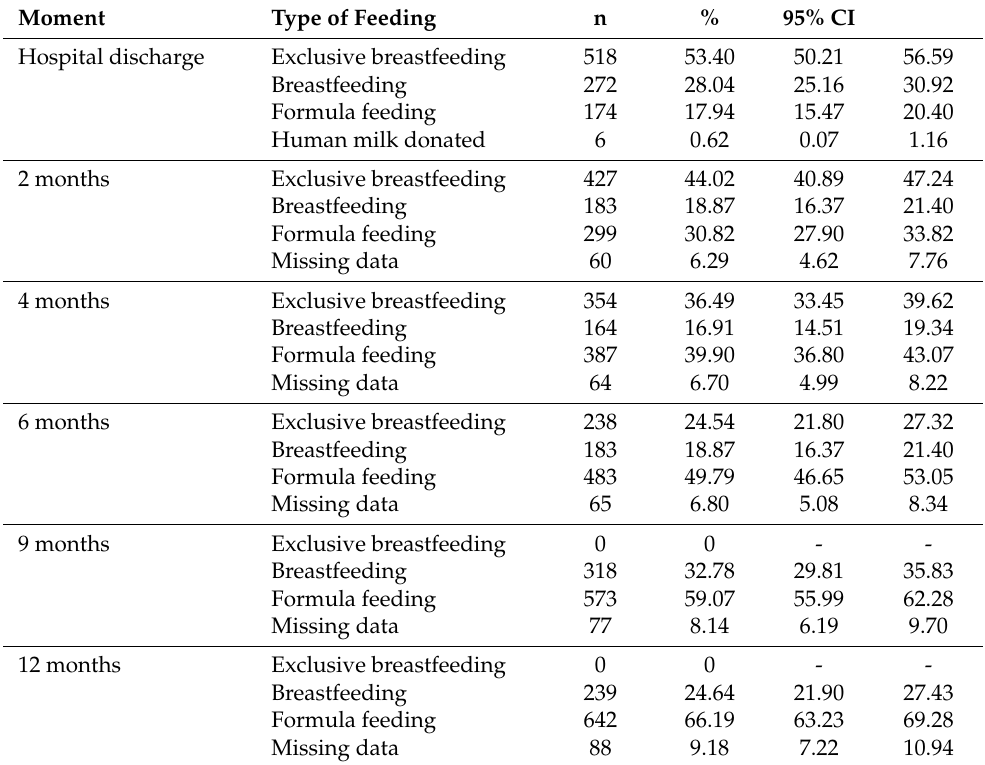
Table 1. Prevalence of breastfeeding and its evolution over 12